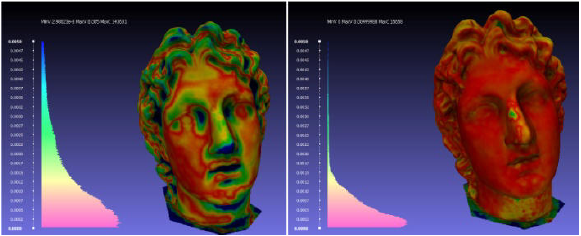
Figure 12. Hausdorff distance calculation between the 3D Creator model and Canon- Photoscan model (on the left), between the Xperia- Photoscan model and Canon- Photoscan models (on the